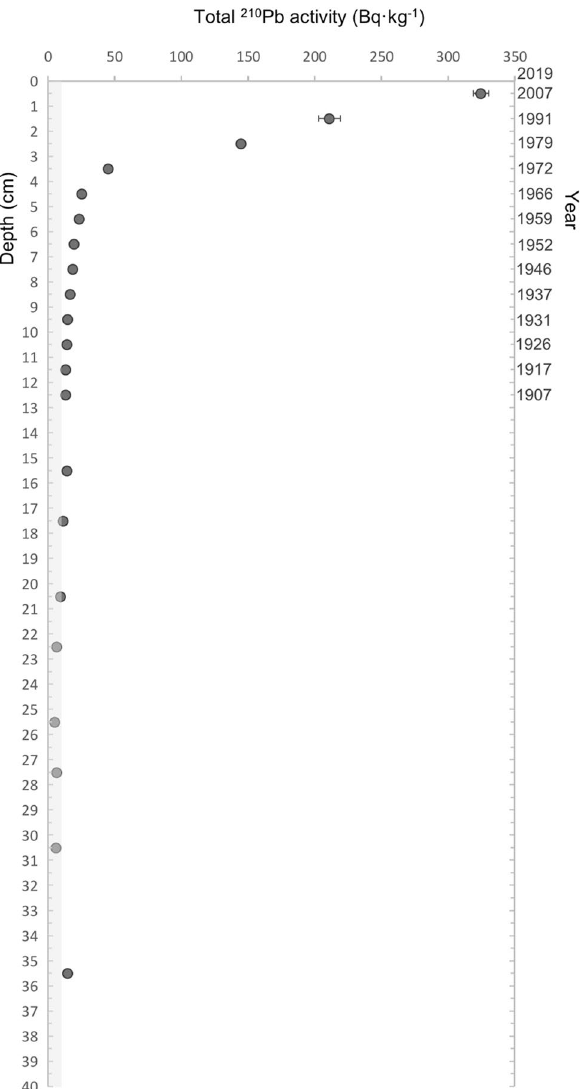
Figure 3. 210 Pb profile along sediment core: Excess 210 Pb concentration (± standard error) along the depth profile (left y axis) and time (right y axis) of the core BS2A1. The grey area represents the supported 210 Pb (9 ± 3 Bq kg −1